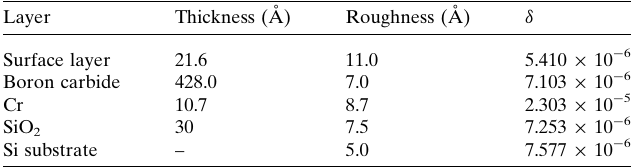
Table 2 GIXRR fit parameters of boron carbide/Cr after 550 (cid:2) C annealing.